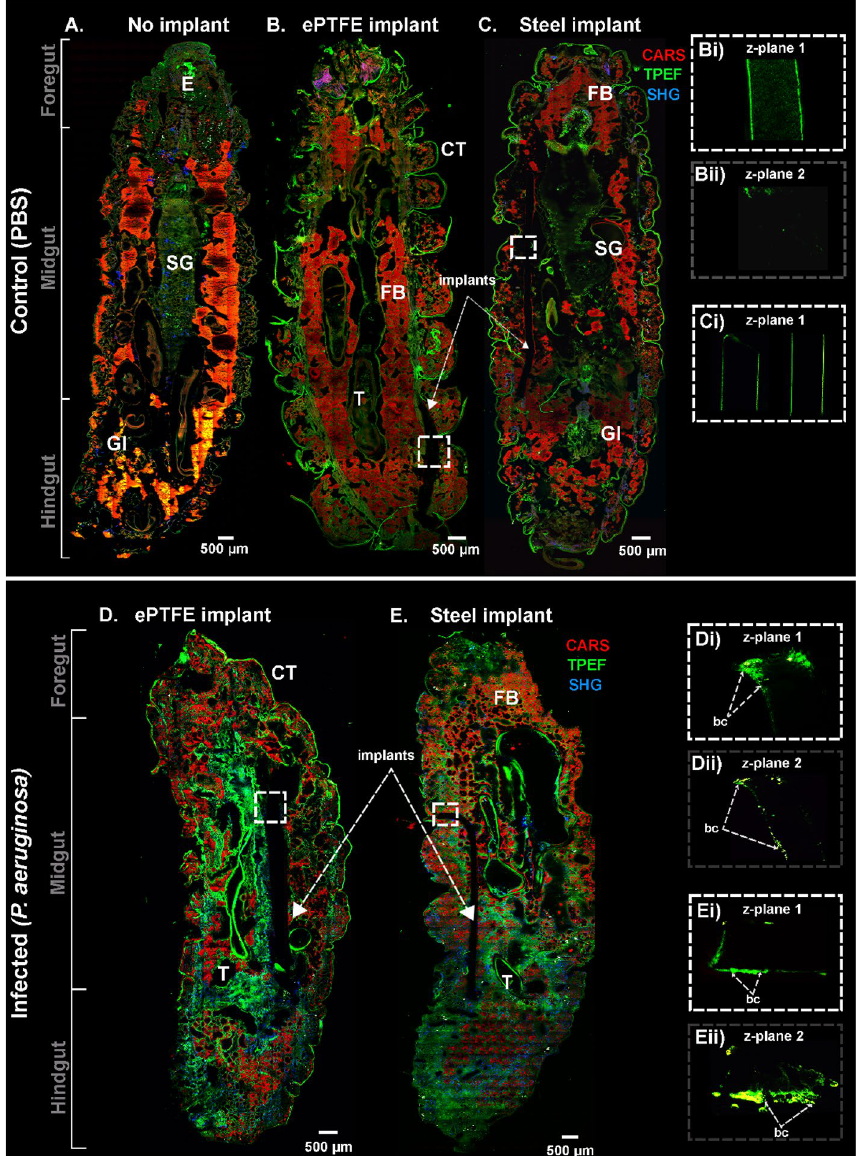
Figure 5. Multimodal images showing the sagittal section of the G. mellonella larval body displaying the entire larvae of control without an implant ( A ), with PBS-incubated ePTFE ( B ) and stainless steel ( C ) implants. G. mellonella with P. aeruginosa (PA01)-infected ePTFE ( D ) and stainless steel ( E ) implants. Multimodal images with CARS (red), TPEF (green), and SHG (blue) channels are overlayed in false colors. The square inset with white dashed lines was zoomed from ( B , C ) to visualize parts of the plastic implant in ( Bi ) and the stainless-steel implant in ( Ci ), respectively. The image shown in ( Bii ) is of the same implant as shown in ( Bi ) but acquired at a different focus depth (gray dashed lines) along the z-axis (z-plane 1 and z-plane 2) of the implants. Similarly, the square inset with white dashed lines was zoomed from ( D , E ) to visualize parts of the plastic implant in ( Di ) and the stainless-steel implant in ( Ei ), respectively. The images shown in ( Dii , Eii ) are of the same implants as shown in ( Di , Ei ), respectively , but acquired at a different focus depth (gray dashed lines) along the z-axis (z-plane 1 and z-plane 2) of the implants. FB = fat body, CT = cuticle, T = trachea, GI = gastrointestinal tract, SG = silk gland, E = esophagus, bc = bacterial